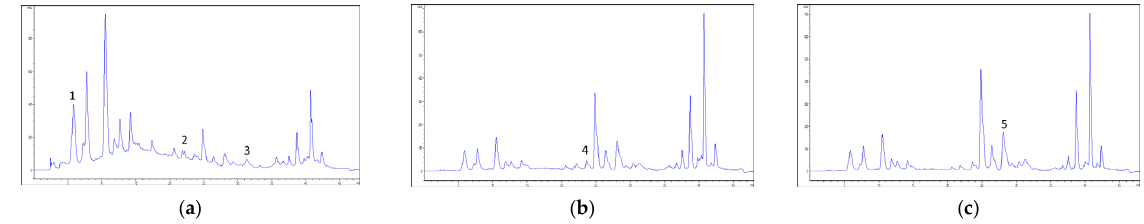
Figure 1. High-performance liquid chromatography coupled to diode array detector (HPLC-DAD) chromatograms of sample P-Et (herb collected at Petaloudes location, extraction with ethanol) with detection at: ( a ) 280 nm, ( b ) 330 nm and ( c ) 350 nm. Detected compounds corresponding to peaks: Table 2. Results of high-performance liquid chromatography coupled to diode array detector (HPLC-DAD) analysis, determining the content of 10 selected compounds. P-Et E-Et P-Aq E-Aq gallic acid (mg/g DE)